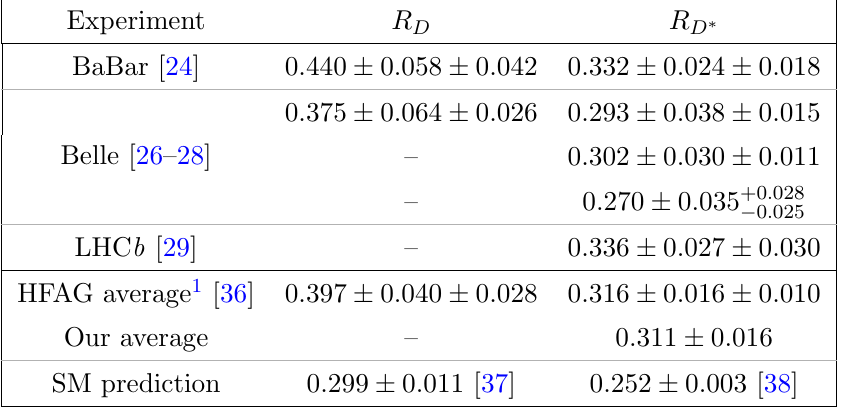
Table 1. A summary of results associated with b ! c(cid:28)(cid:23) . Our average includes the most recent Belle measurements of R , it is calculated by taking an error-weighted mean after summing statistical D (cid:3) and systematic uncertainties in